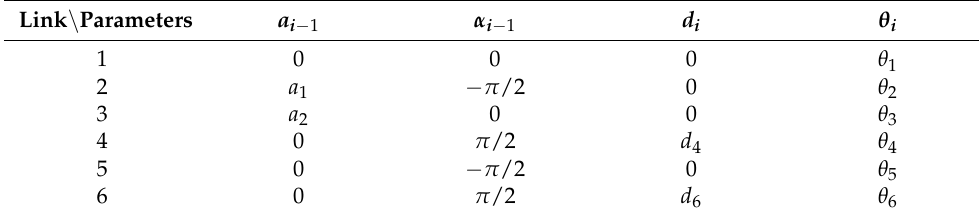
Table 2. D-H parameters of industrial robots. Link \